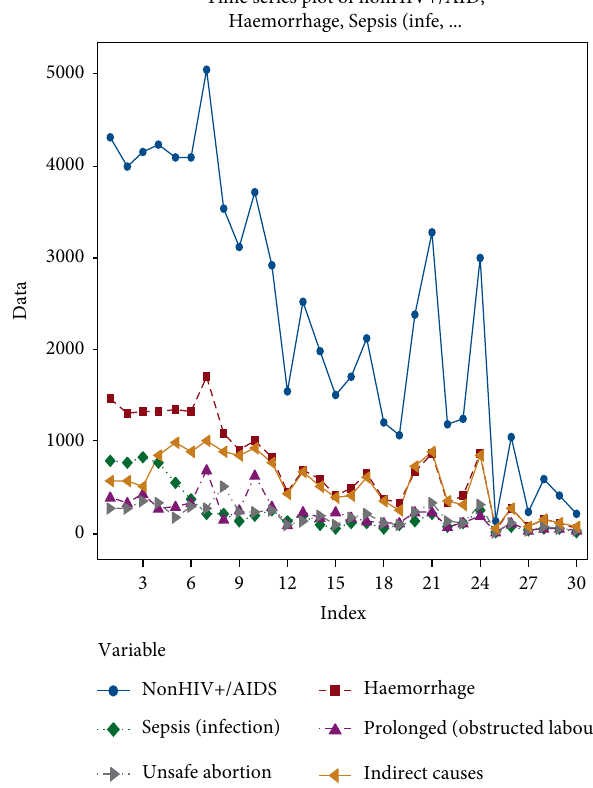
Figure 3: Time series plot of the five main causes of MMR in South Sudan between 1986 and